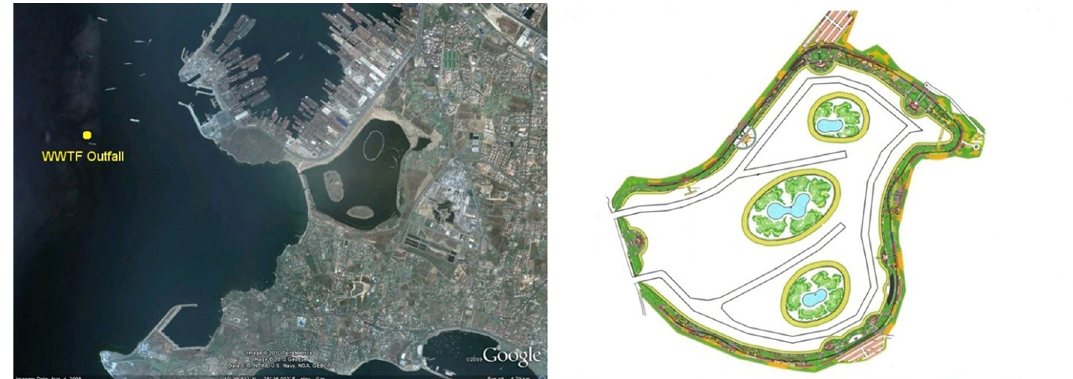
Figure 2. The modeling domain. The figure on the left shows the current condition while the drawing on the right is the simulated configuration. The yellow dot on the figure on the left shows the approximate location of the WWTF outfall (Picture credits: Left, Google Maps. Right, Municipality of the Town of Tuzla, Istanbul, Turkey)